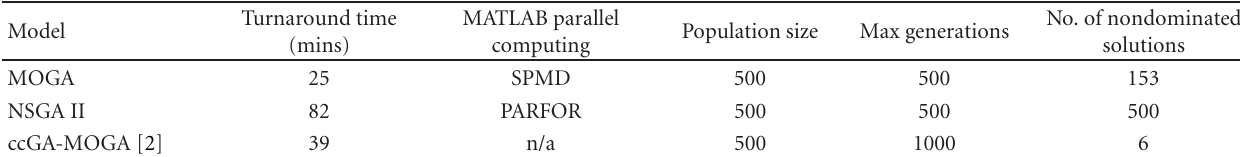
Table 3: Summary of the approaches for the E. fastigata optimal thinning regime problem using MOGA, NSGA II, and ccGA as computed on a MacBook Pro with a 2.93GHz Intel Core 2 Duo processor.